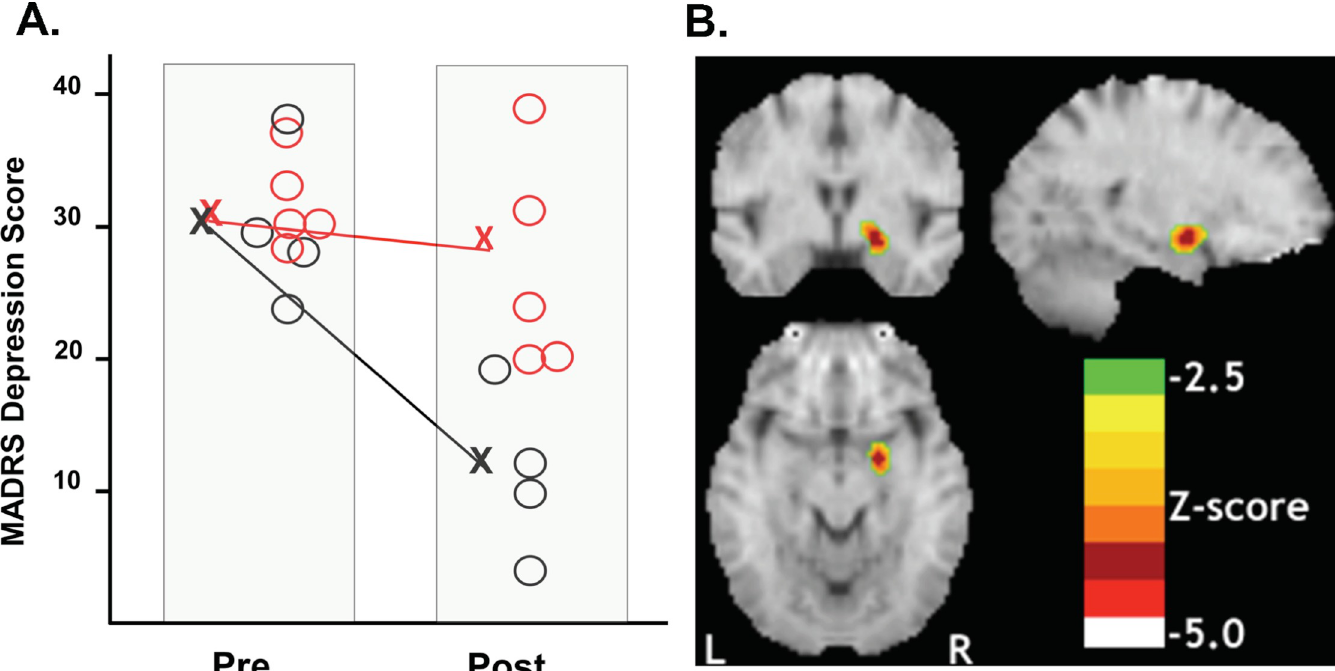
Fig 2. Changes in depression ratings and regional glucose uptake before and after treatment. ( A) Individual MADRS scores of the responders and non-responders before and after treatment. (N = 9). Non-Responders, red circle; responders, black circle. X denotes group means. (B) Right amygdala metabolism in the brain of responders following olanzapine/fluoxetine treatment was the only significant decrease in the whole-brain voxelwise analysis. Upper left section, coronal; lower section, transverse; upper right section, sagittal.